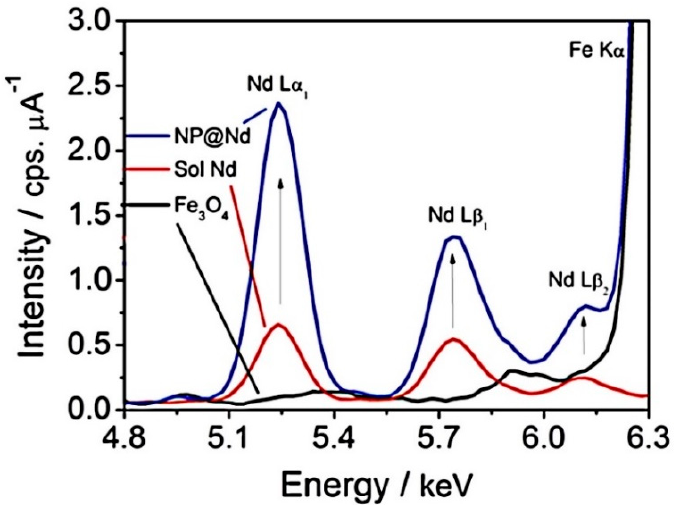
Figure 6. Typical X-ray fluorescence spectra of the Fe 3 O 4 nanoparticles, of the neodymium nitrate solutions at 25 mmol L − 1 , and of the nanoparticles after the capturing of Nd 3 + ions (adapted with permission from